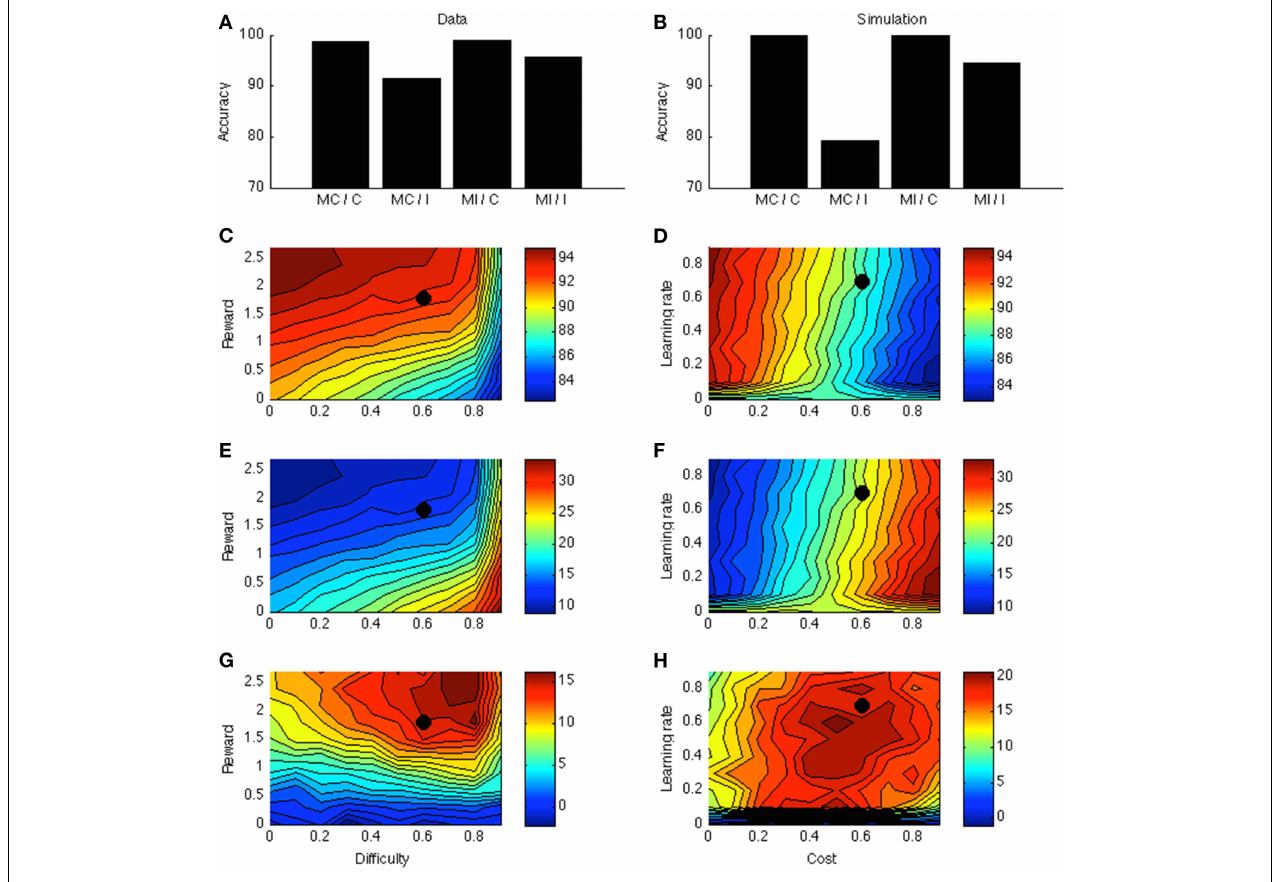
effect across reward and difficulty. (F) Simulated congruency effect across learning rate and cost. (G) Simulated PC effect across reward and difficulty. (H) Simulated PC effect across learning rate and cost. Black dots in (C–H) indicate the parameter used to generate (B)